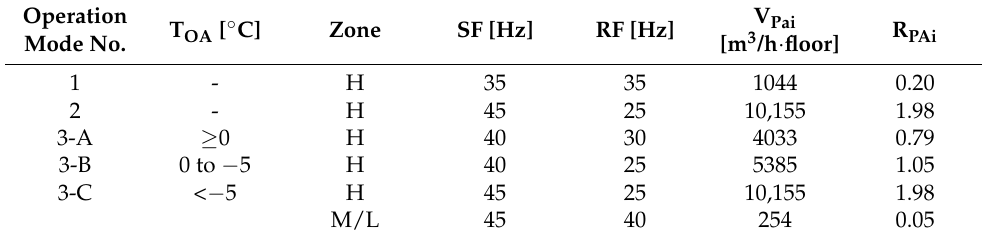
Table 2. HVAC system operating conditions in winter